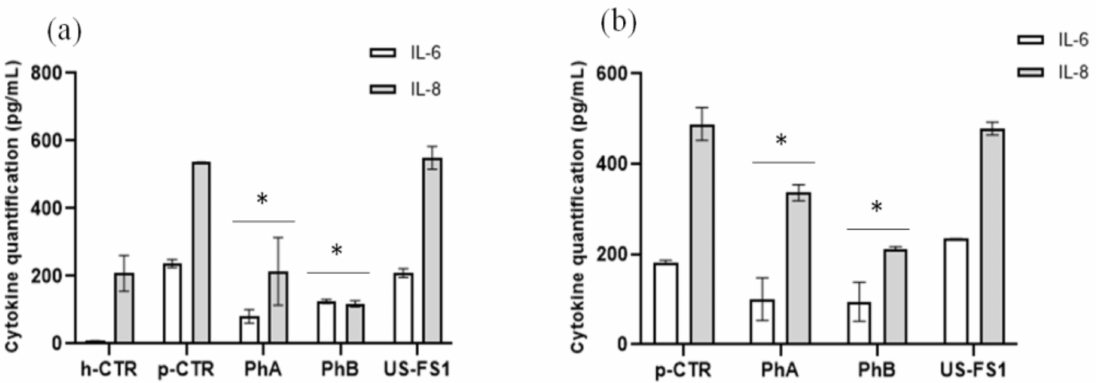
Figure 6. ELISA assay for IL-6 and IL-8 on chondrocytes ( a ) and synoviocytes ( b ) treated with US FS in comparison to PhA and phB pharma grade samples at 48 h of incubation. The values presented are the averages ± S.D. Significant differences are indicated as * p < 0.01 vs.